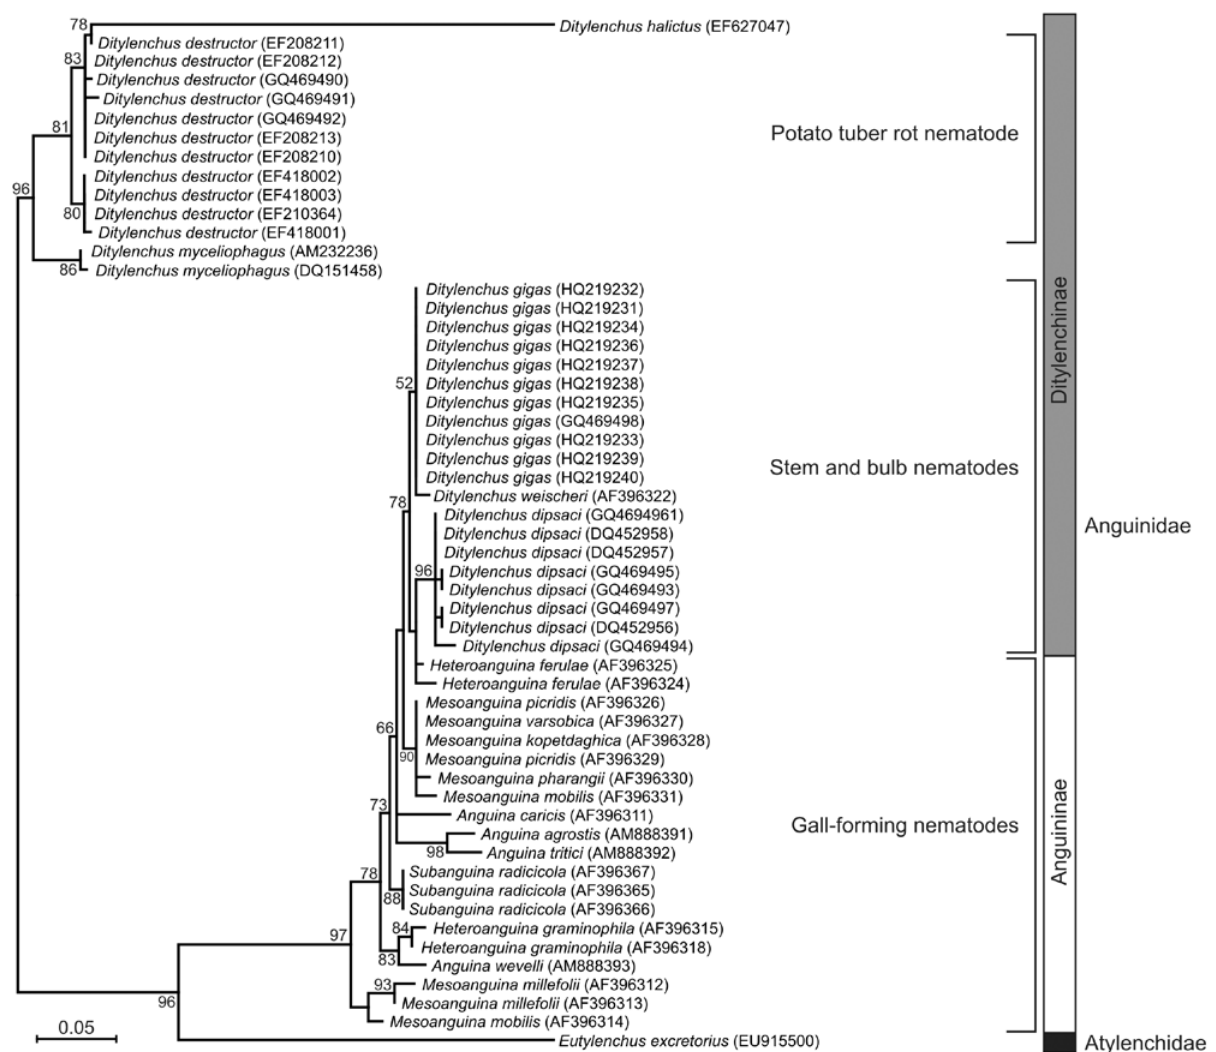
Figure 7. Maximum likelihood tree built up from the ITS1-5.8S-ITS2 rDNA sequence data. Fifty-four ITS-rDNA nucleotide sequences of anguinid species were aligned with help of ClustalX. All positions containing gaps and missing data were eliminated from the dataset, and phylogenetic analysis was conducted in MEGA4. Sequence of Eutylenchus excretorius (Tylenchida: Atylenchidae) was used as outgroup. Numbers at branches denote percentual bootstrap values (out of 500 replicates), and numbers in the brackets indicate GenBank